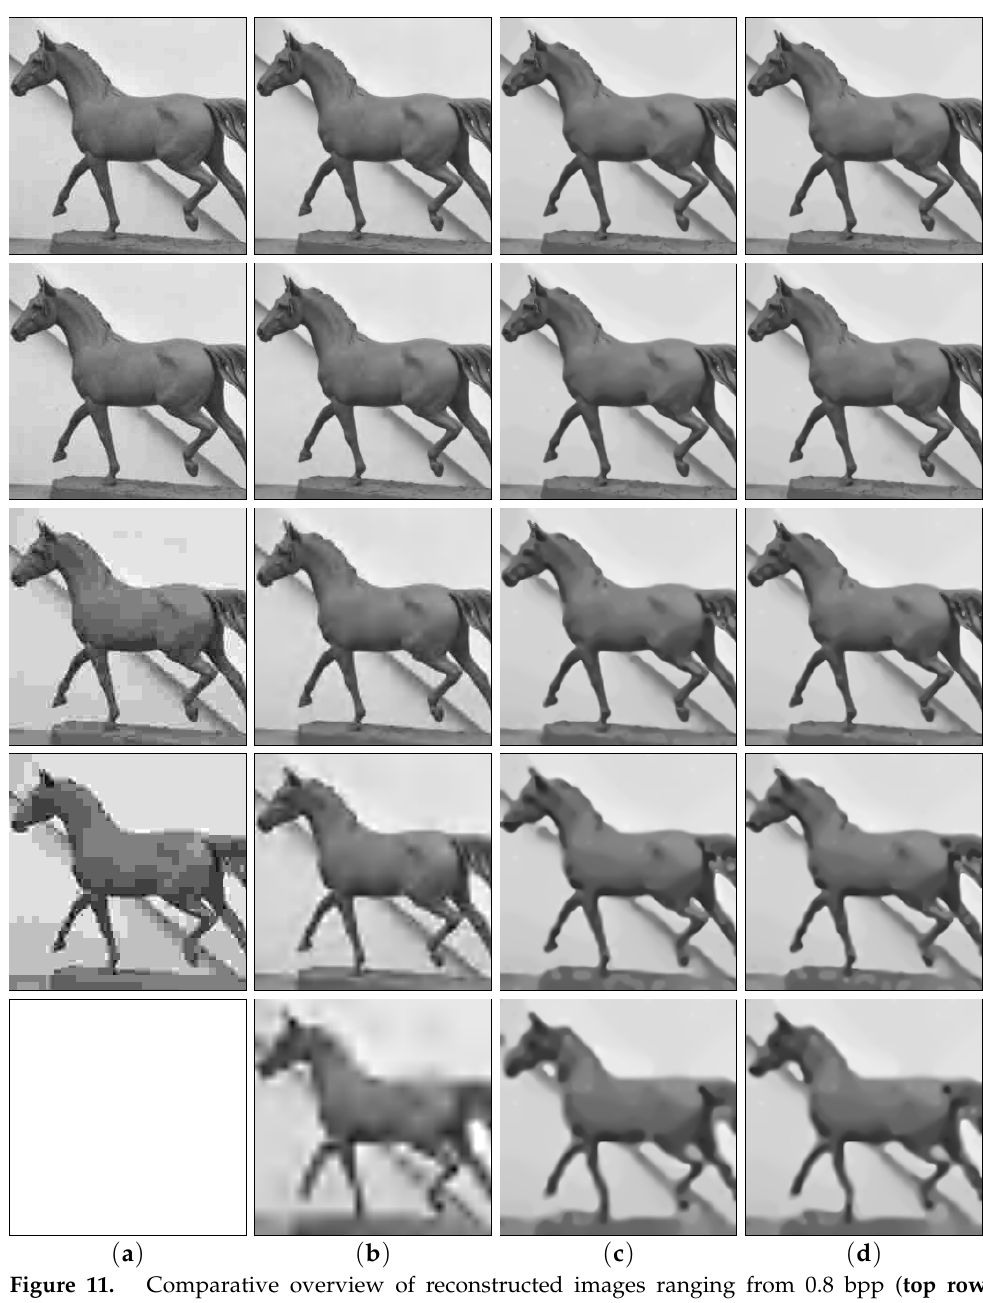
Figure 11. Comparative overview of reconstructed images ranging from 0.8 bpp ( top row ) to 0.05 bpp ( bottom row ). Compression methods: ( a ) JPEG, ( b ) JPEG 2000, ( c ) EEDC i, and ( d ) EEDC-RANGE (BWT).